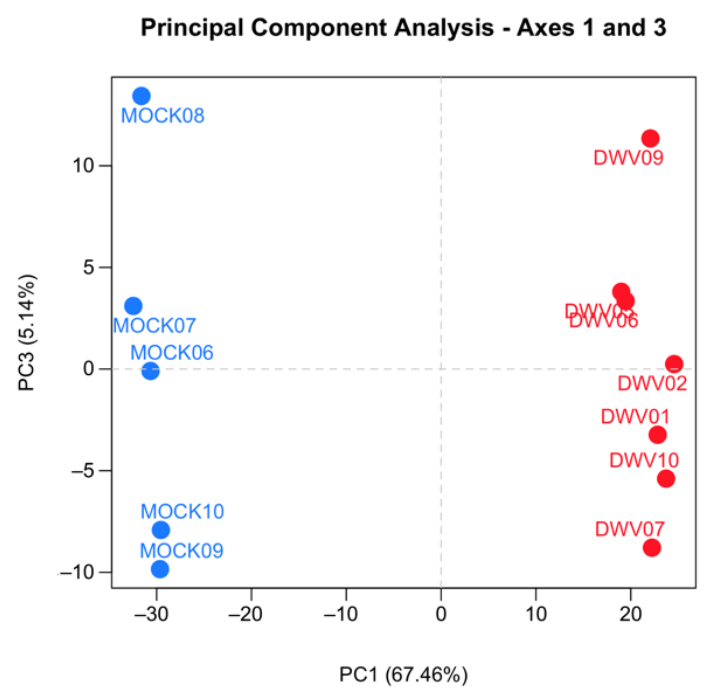
Figure 1. Principal component analysis (PCA) of the RNA-Seq data from the samples used in the final analysis. The gene expression profiles from the five mock (blue circles) and seven deformed wing virus (DWV, red circle) infected honey bees are presented. The PCA was performed on pairwise gene comparisons after variance-stabilizing transformation on the counts using DESeq2. Points that are closer together are more similar in gene expression.